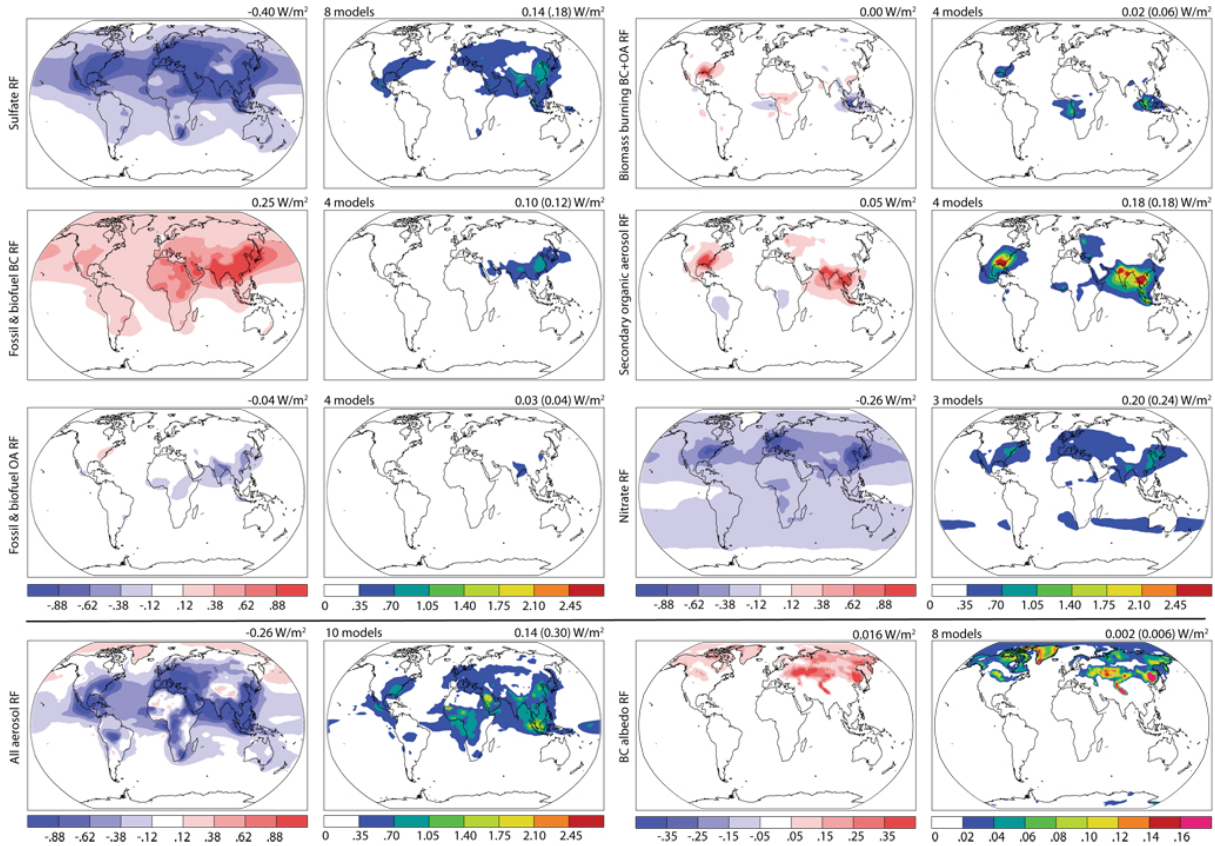
Fig. 11. Industrial era multi-model mean (left columns) and standard deviation (right columns) of RF for each aerosol component (top three rows), all aerosols (lower left) and BC albedo (lower right; note change in scale). Global means are in the upper right corner, with standard deviation of the global mean values from each model given first followed by the global mean of the standard deviation at each